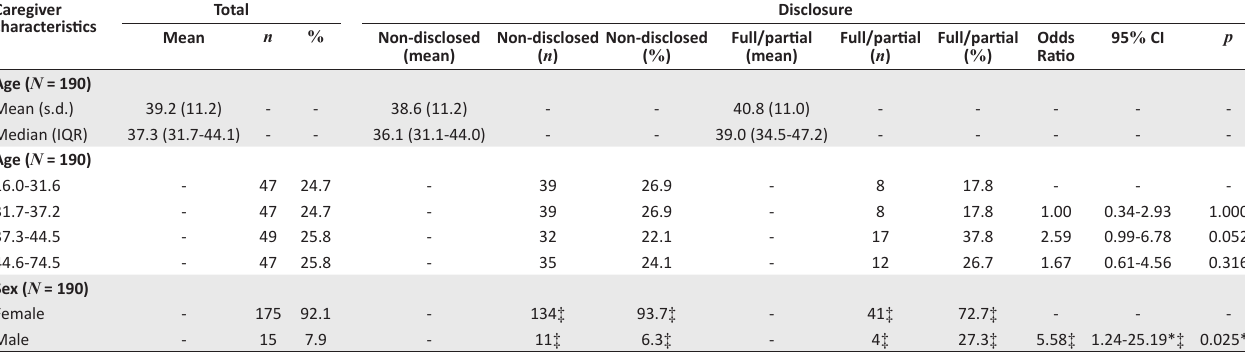
TABLE 2: Associations between disclosure and caregiver characteristics – Univariate analyses. Caregiver